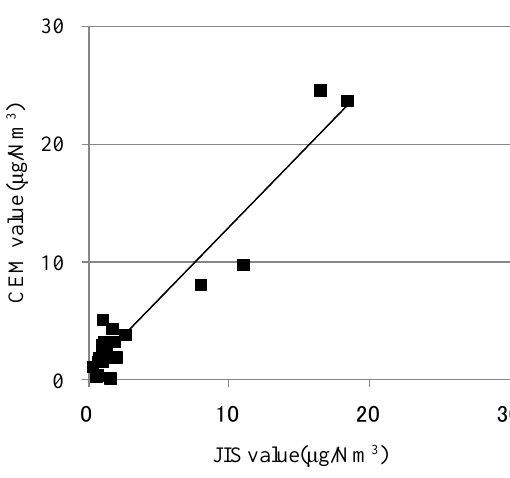
Figure 2. The relationship between the JIS and CEM methods. Fig. 2. The relationship between the JIS and CEM methods.